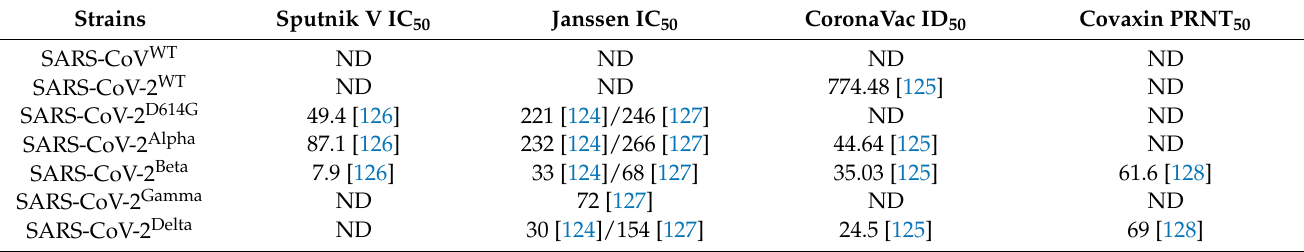
Table 4. Sensitivity of sera induced by Sputnik V, Janssen, CoronaVac and Covaxin vaccines. The sensitivity of neutralizing antibodies induced by vaccines is superior in ancestral SARS-CoV-2 and, in general, the performance of this sensitivity is reduced against any SARS-CoV-2